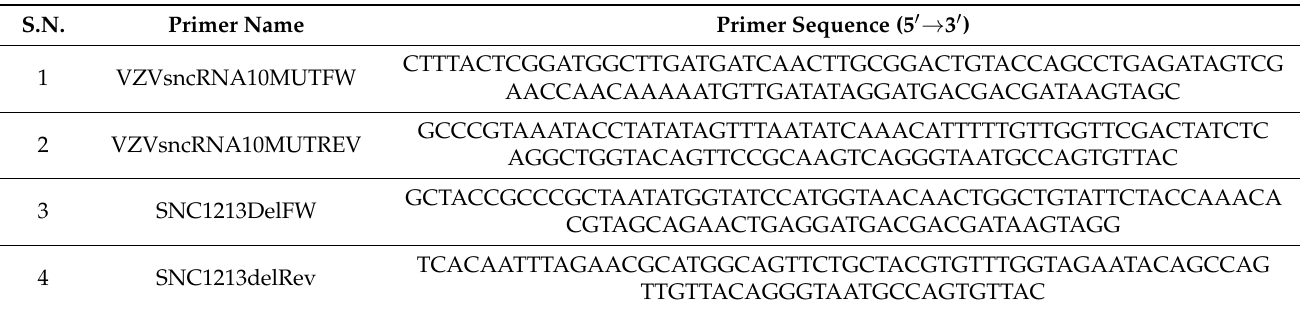
Table 1. Oligonucleotides used for making mutant viruses. S.N.